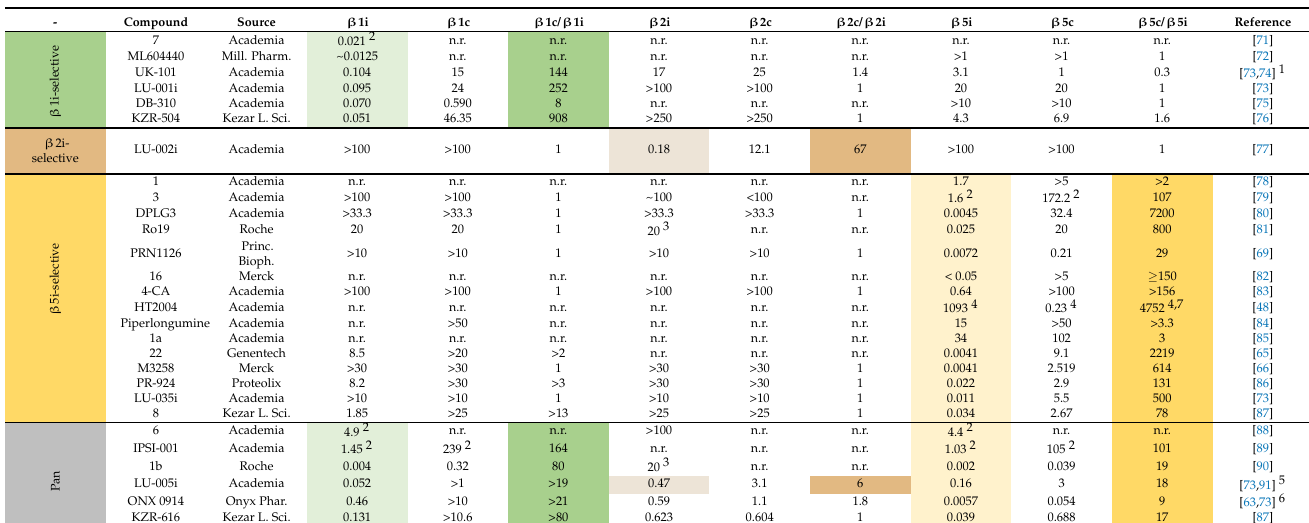
Table 1. Overview of iCP selective inhibitors and their potency. Due to space limitations, only key compounds of each class are presented. IC 50 values (given in [ µ M]) depend on the chosen setting (purified CP/cell lysate/in cells), enzyme concentration and time of incubation, and thus are hardly comparable. As a measure of subunit selectivity, ratios of IC 50 values are given. The ratio positively correlates with selectivity for the respective i-subunit. ‘n.r.’ designates values that have not been reported. Colors reflect the distinct selectivity patterns of inhibitors: green for β 1i-, brown for β 2i-, yellow for β 5i- and gray for pan-reactive inhibitors. Inhibition values are light-colored, while selectivity ratios are dark-shaded. Most pan-reactive inhibitors target β 1i and β 5i (green and yellow shades, respectively). Only LU-005i moderately inhibits all immunoproteasome subunits (green, brown and yellow shades).